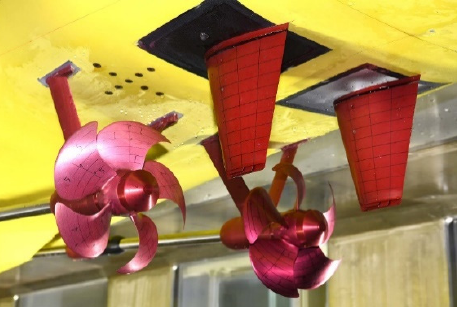
Figure 13. Photo of ship, propeller, and flat-type rudder models. Table 4. Particulars of the rudder.